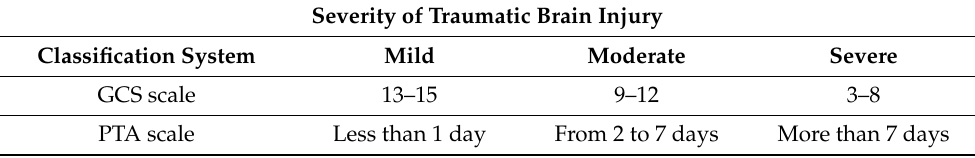
Table 2. Defining the severity of traumatic brain injury on the basis of Glasgow coma scale (GCS) and post-traumatic amnesia (PTA) classification